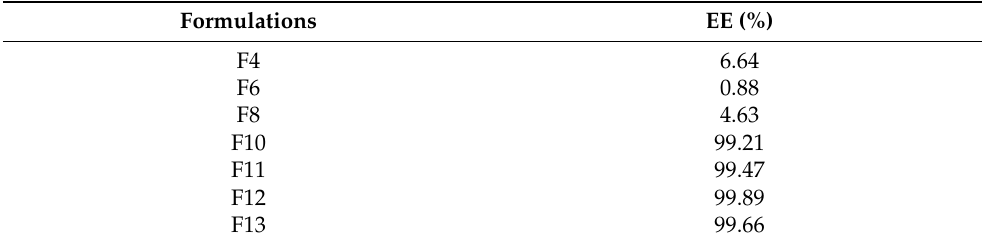
Table 4. Encapsulation efficiency (EE) of selected